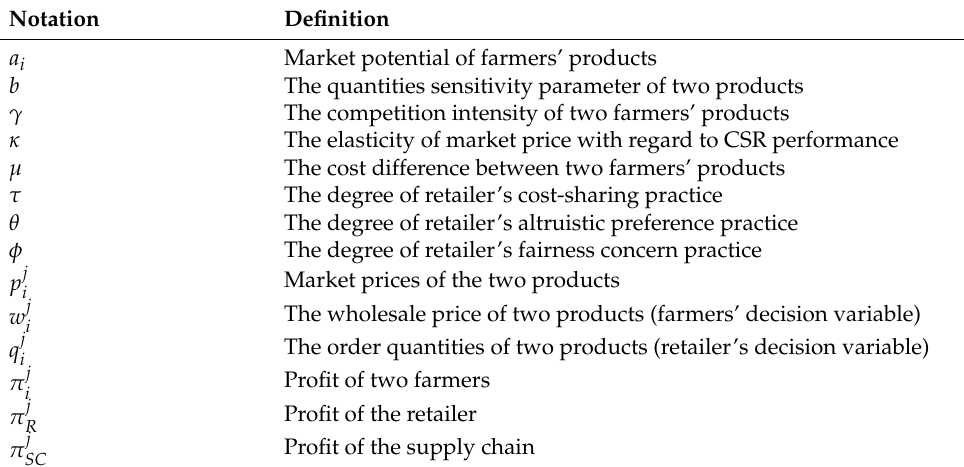
Table 3. Summary of